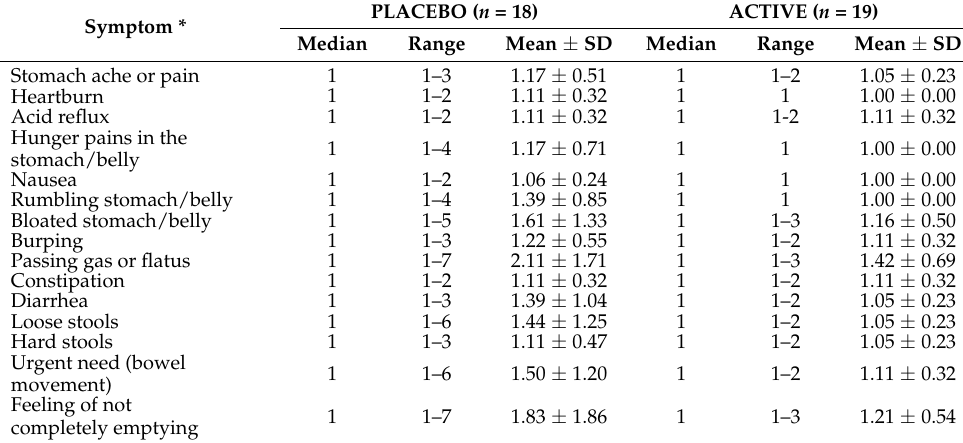
Table 4. Gastrointestinal symptom scores according to Gastrointestinal Symptom Rating Scale (GSRS) in the two experimental groups expressed as median value, range, and mean values ± standard deviation at the end of